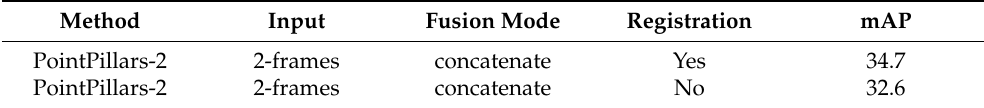
Table 2. Comparison between concatenation-based fusion method with and without